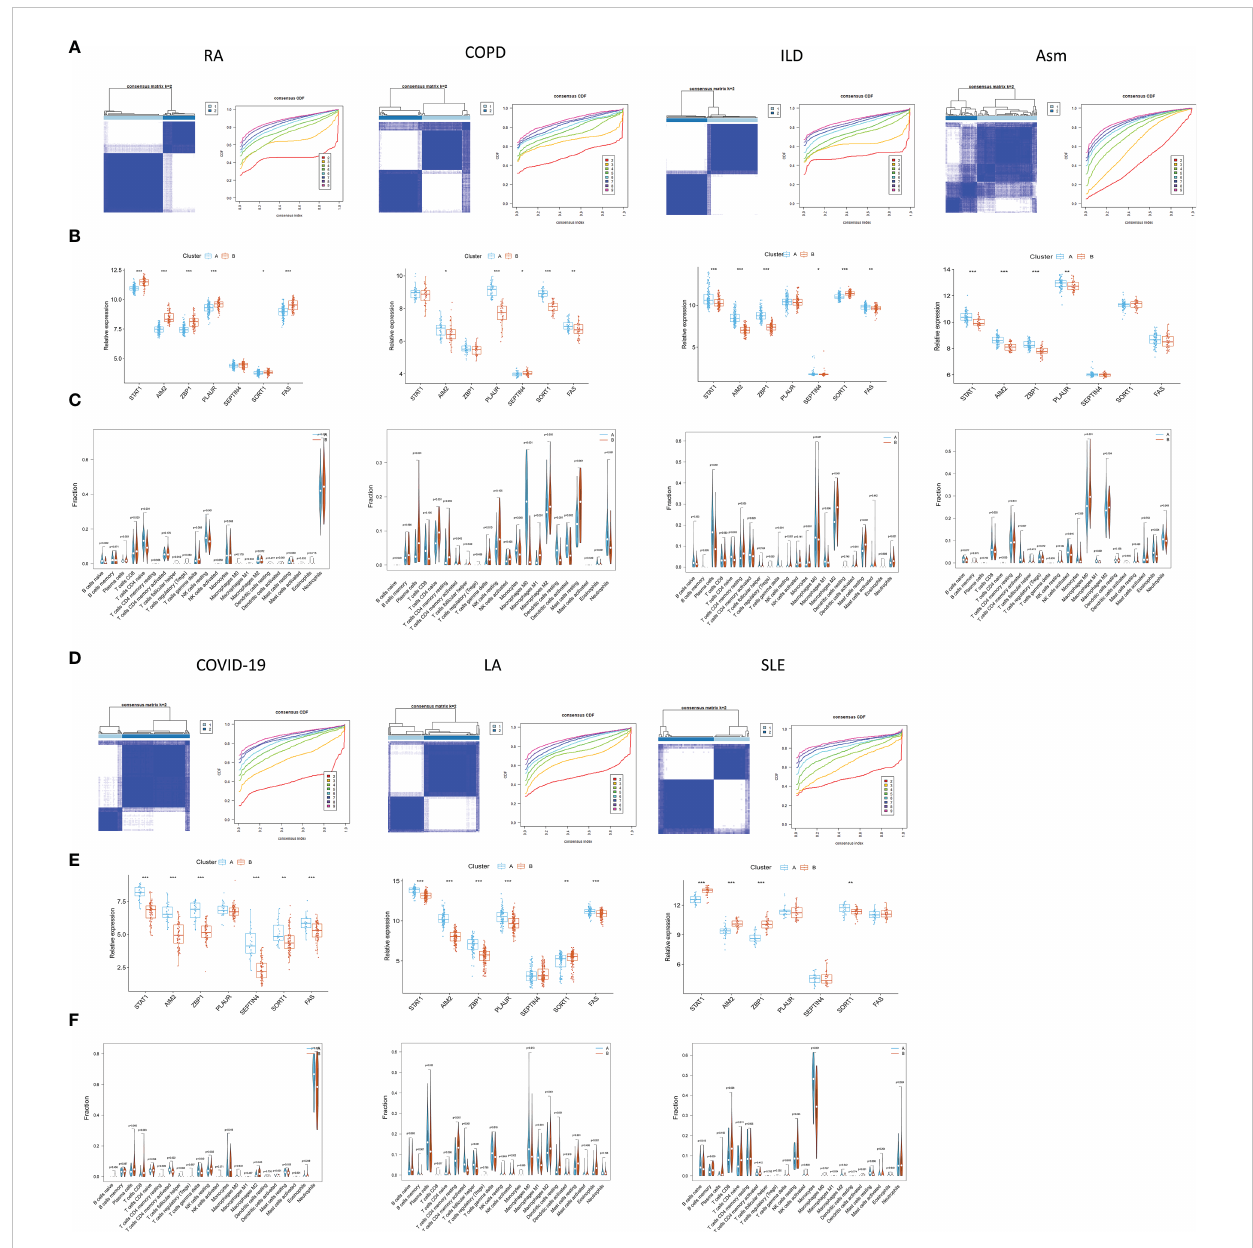
FIGURE 12 Identi fi cation of PCD-related subtypes in TB-related diseases. (A, B, D, E) Subclustering analyses were performed based on differentially expressed genes in different diseases. (C, F) PCD-related gene expression in different